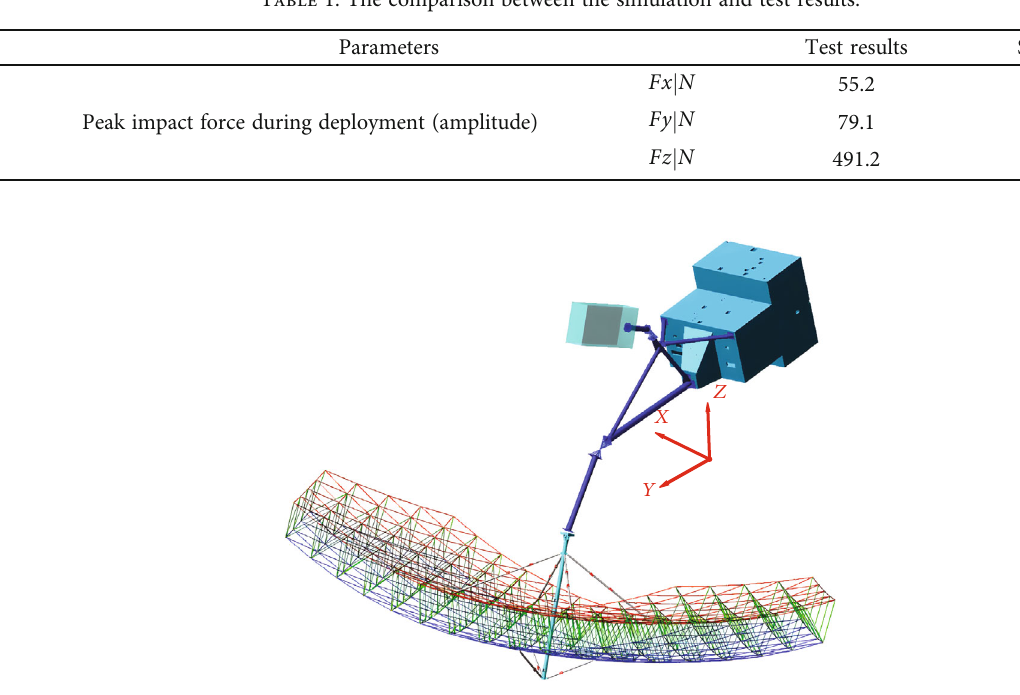
Table 1: The comparison between the simulation and test results.